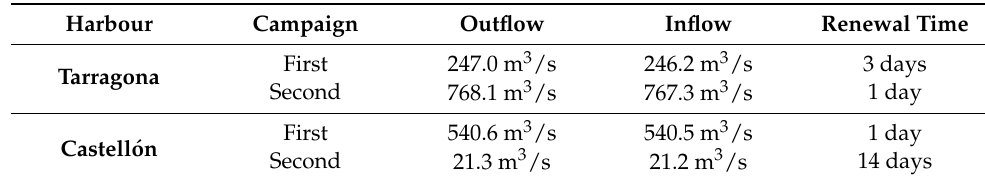
Table 5. Flows and renewal times (RT) calculated for Tarragona and Castell ó n harbours, derived from the box model proposed in the paper.